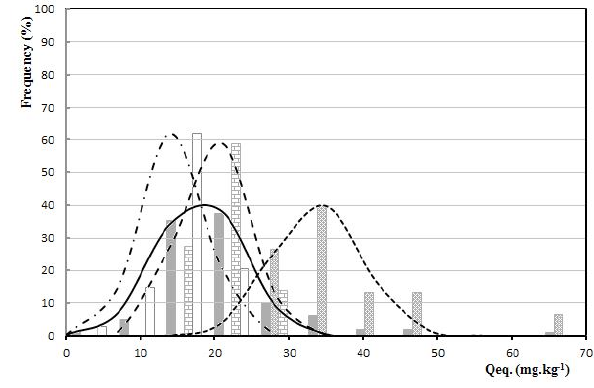
Figure 5: Distribution of total flavonoids in oats expressed as quercetin equivalent (solid column and line – complete set, r 2 = 0.976, bracket column and dash line – minor, red subset, r 2 = 0.856, dots column and dash-and-dot line – major, green subset, r 2 = 0.999, empty column and dots line – major, blue subset, r 2 = 0.998, the mentioned colors correspond to the colors in Fig. 2 and Fig.